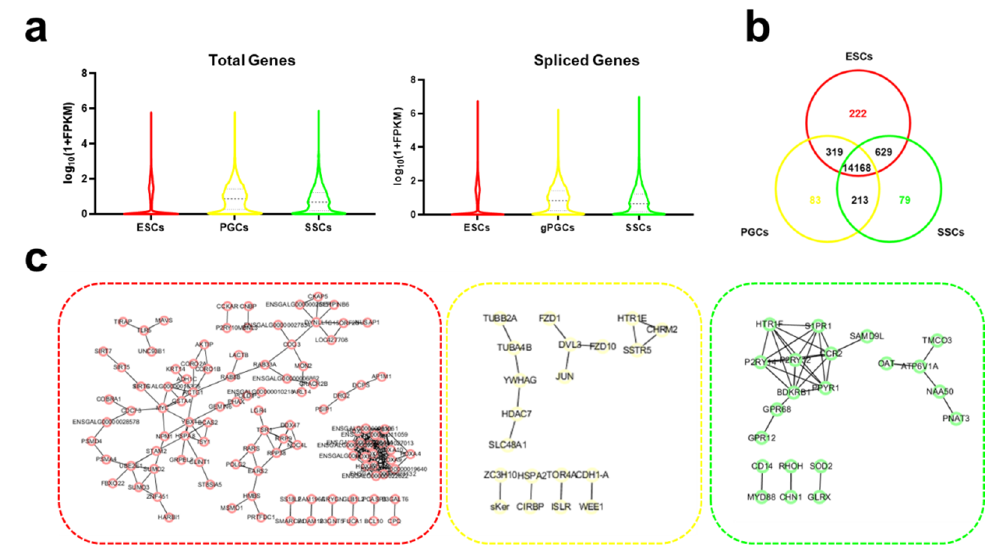
Figure 3. A cell-type-specific spliced gene in ESCs, gPGCs, and SSCs . ( a ) The expression patterns of total genes and spliced genes during male chicken germ cell differentiation. ( b ) Differentially spliced genes among three cell types. ( c ) The gene network of cell-specific spliced gene groups. The red dotted line is the ESC-specific spliced gene–gene interaction network; the yellow dotted line is the gPGC-specific spliced gene–gene interaction network; and the green dotted line is the gPGC-specific spliced gene–gene interaction network.